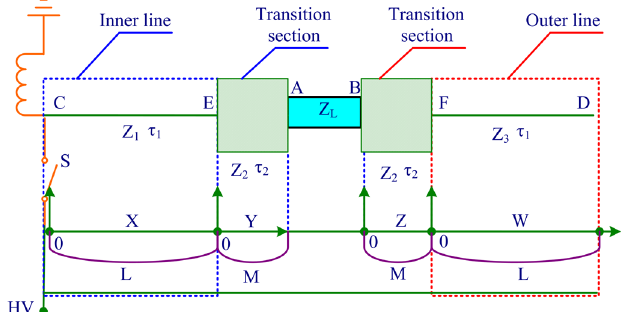
load.FIG. 1. (Color) Diagram of the IEBA based on the pulsed transformer and